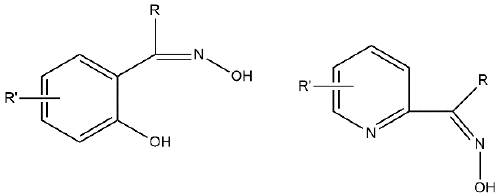
Figure 21. Salicyl aldo(keto)ximes (left) and 2-pyridyl aldo(keto)ximes (right), two families of ligands that have widely been used in the chemistry of transition-metal SMMs; R and R’ are various non-donor groups. When R = H the ligands are aldoximes and when R (cid:44) H the products are ketoximes. An in-depth studied family of Mn(III) carboxylate clusters consists of the triply oxido-bridged, triangular complexes [Mn 3 O(O 2 CR”) 6 L 3 ]X (R” = Me, Et, Ph, . . . ; X = monoanionic counterions; L =